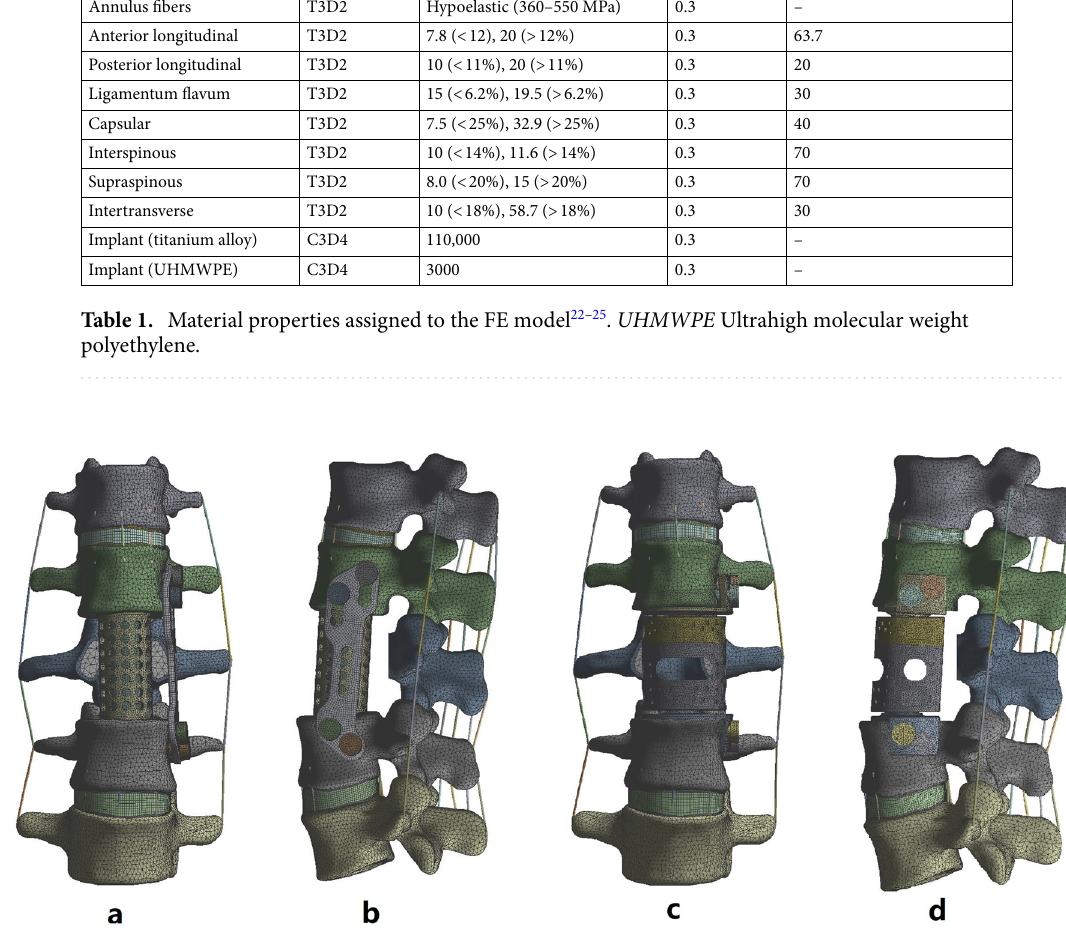
Figure 7. The FE models after prothesis implantation: a front view of the FE model of the fusion group, b lateral view of the FE model of the fusion group, c front view of the FE model of the nonfusion group, and d lateral view of the FE model of the nonfusion